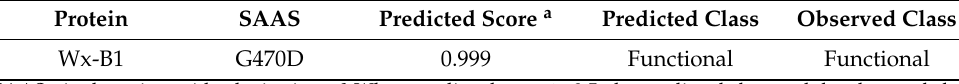
Figure 2. Protein structure of GBSSI representing the position of specific domain and representative impacts of amino acid residue substitutions at 470 on residue accessibility to solvent and hydrogen bond forces surrounding the amino acid residues. ( a ) NCBI analysis predicting the function domains in tetraploid wheat GBSSI sequences. ( b ) The Swiss-pdb viewer required for ADPG binding in GBSSI were homology modeling, and it was derived using an EcGS structure (PDB, 3GUH) as a model. The ADPG binding pocket is shown by the red box. The mutation point is shown by the red arrow near the ADPG binding pocket representing the G-to-D mutation. ( c ) Protein structure with the original amino acid G470. ( d ) Substitution of amino acid D470 and its effects on the protein structure. Residues are shown in red, turquoise, or blue, which indicate their solvent accessibility ranging from high to low. Hydrogen bonds between the residues of interest and their surrounding atoms are shown. The green dashed line indicates strong hydrogen bonds. In addition, the length of the hydrogen bonds connecting the atoms is also shown. Table 1. The prediction results of Wx-B1 protein.